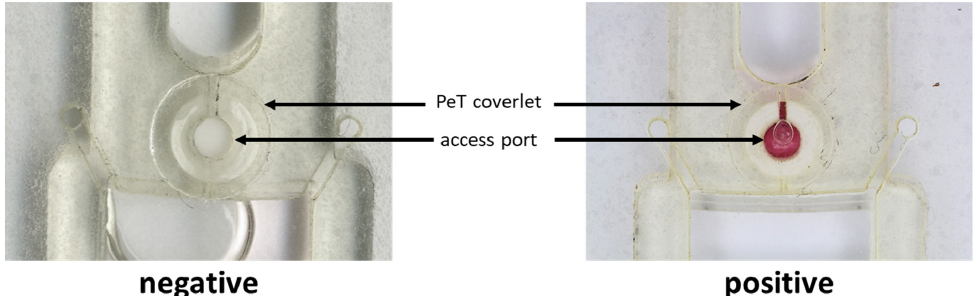
Figure 6. On-disc immunodetection of Ebola virus-like particles (bottom view). The cOF disc was redesigned with circular 2 mm port in disc layer 5 (directly below the OF fluidic port). The exposed cOF membrane was spiked with 5 μ L of a primary capture antibody solution [10 ug/mL]. After drying (30 min@30 °C), each cOF access port was sealed with a 6 mm diameter PeT coverlet. Positive samples consisted of 40 μ L of Ebola virus-like particle antigen [10 μ g/mL], 5 μ L Au tagged mAb, and 5 μ L assay buffer. Negative samples consisted of 5 μ L Au tagged mAb and 45 μ L assay buffer. Spin protocol: 15 s spin cycles at 250 rpm intervals beginning at 1000 and ending at 3000 rpm.